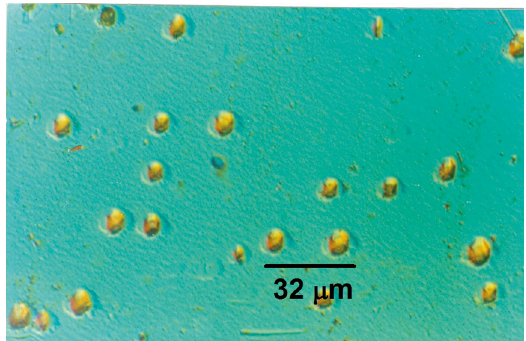
Ga As surface, x=0.3. x 1-x